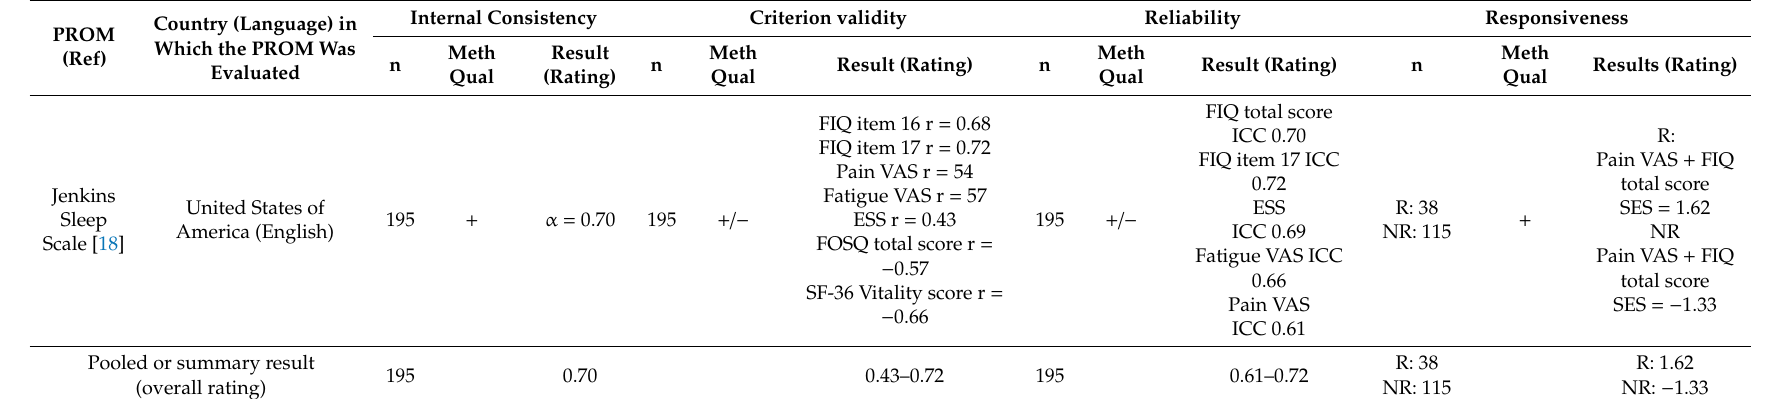
Table 6. Results of studies on measurement properties